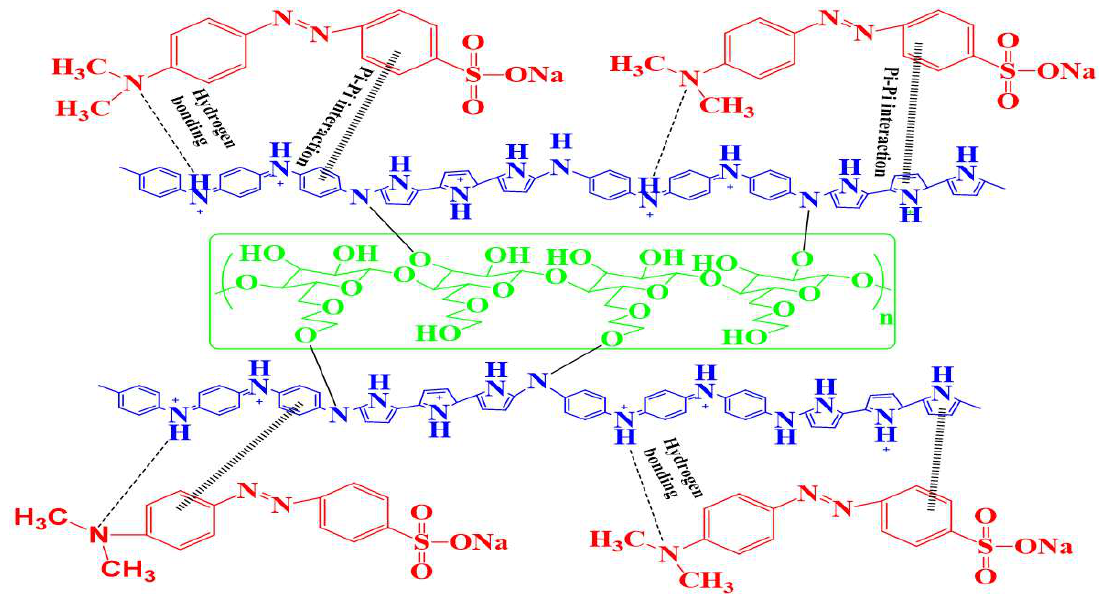
Figure 1. Schematic representation of HEC/PANI-PPy and dye adsorption. Table 1. Adsorption capacities of some famous adsorbents for MO and RhB. Adsorbent Dye Adsorption Capacities (mg/g)